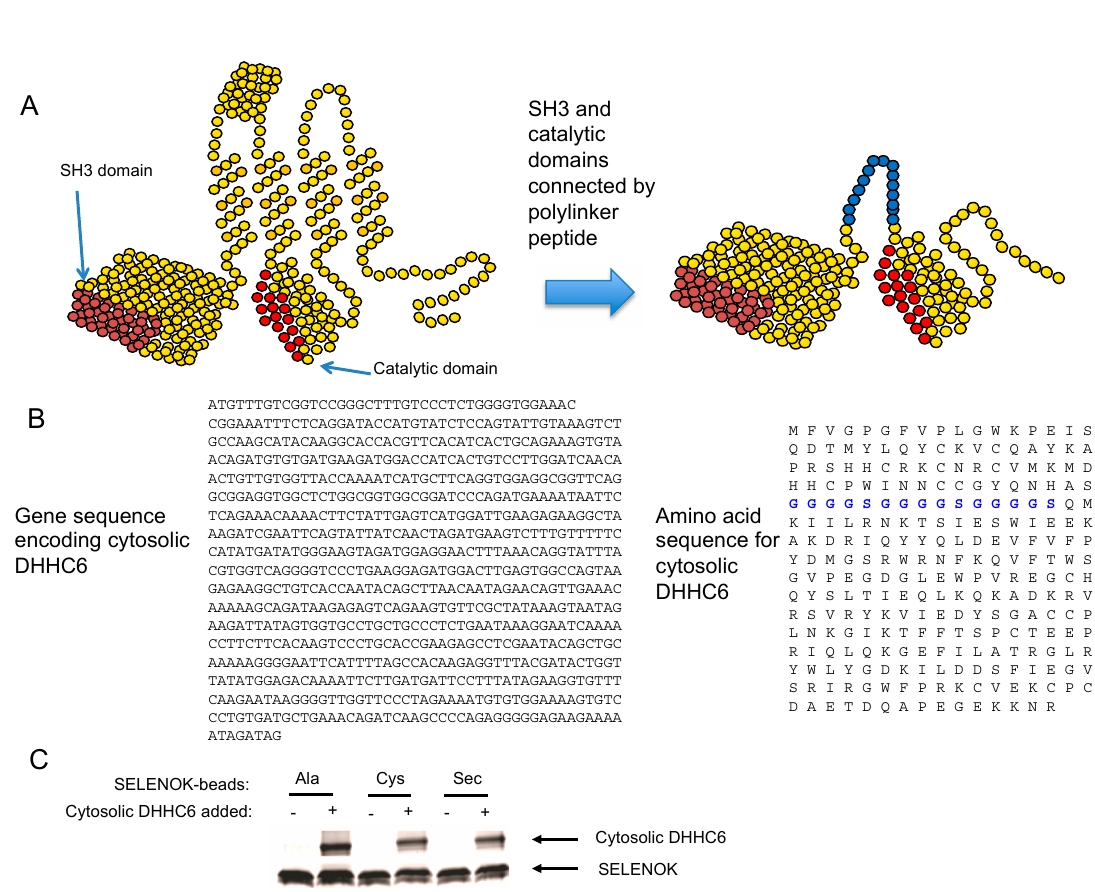
Figure 3. Synthesis of a soluble cytosolic DHHC6 that binds to SELENOK. ( A ) Illustration of full-length DHHC6 with the SH3 and catalytic domains that were used to construct a modified version of DHHC6, which contains both domains connected by a linker domain shown in blue. ( B ) The DNA sequence used to express the cytosolic DHHC6 along with amino acid sequence showing linker region in blue. ( C ) StrepTactin beads were used to pull down 1 μ g streptavidin-tagged SELENOK containing either Ala, or Cys, or Sec at amino acid position 92. These beads were divided into two aliquots that were not or were incubated overnight at 4 °C with the cytosolic DHHC6 in a 1:1 molar ratio. Eluted proteins were analyzed by Coomassie blue staining of PAGE, and results show all three versions of SELENOK bound to cytosolic DHHC6. Note that some degradation of the recombinant SELENOK occurred during the overnight incubation giving rise to double bands. Also, these are recombinant proteins and not cell lysates, which leads to no detectable background in lanes corresponding to the “no Cytosolic DHHC6 added” conditions.